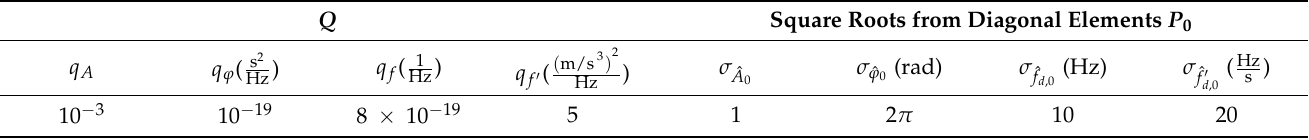
Table 1. Initial parameters of the proposed tracking system. Q Square Roots from Diagonal Elements P